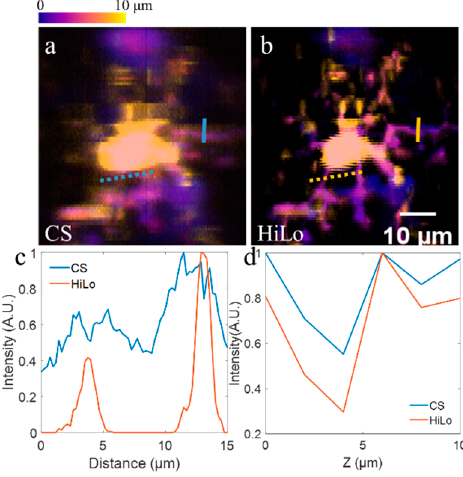
Figure 4. Volumetric imaging of microglia cells in CX3CR1-GFP mouse brains. ( a – b ) Depth color coded stack (thickness = 10 μ m) based on virtual confocal slit detection (CS) and our proposed HiLo method (HiLo), respectively. ( c ) Profiles of dotted lines in ( a , b ), with each profile being normalized. ( d ) Gaussian-fitted peak intensity along solid lines in ( a – c ) versus axial plane.